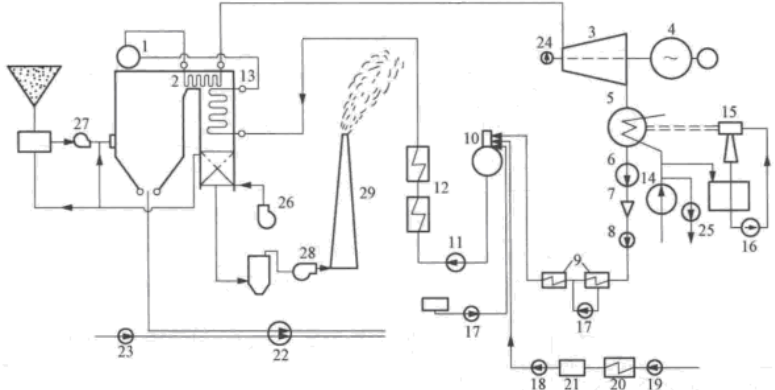
Figure 1. Schematic diagram of thermal power plant system. 1—boiler drum; 2—superheater;